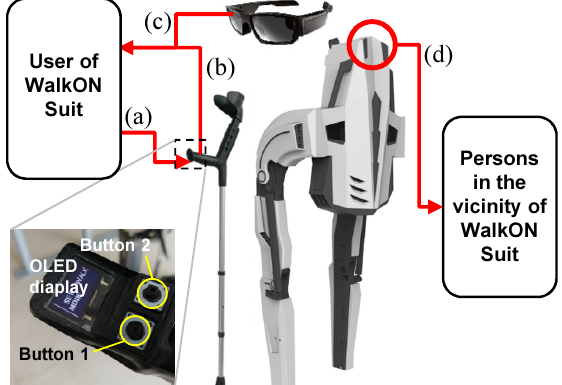
Figure 5. Configuration of the UI of the WalkON Suit. The UI includes ( a ) two tact switches and ( b ) an OLED display installed on a crutch, ( c ) see-through display glasses, ( d ) a multi-color LED on a backpack and a